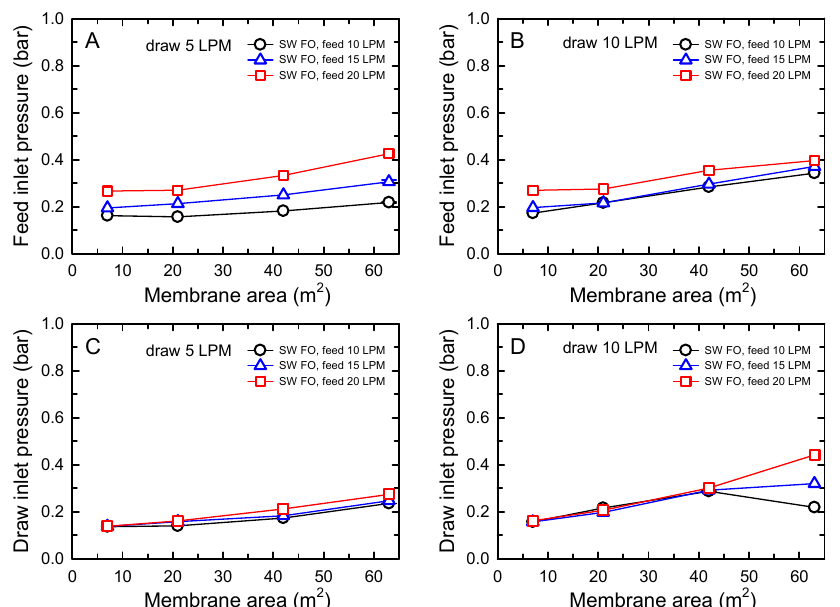
Figure A2. Inlet pressures in feed and draw channels of plate-and-frame (PF) forward osmosis (FO) as a function of membrane area. The applied direct solution (DS) flow rates were 5 ( A , C ) and 10 LPM ( B , D ). The feed solution (FS) flow rates were fixed at 10 LPM. The membrane areas were adjusted via serial connection of 1, 3, 6, and 9 elements of PF FO. The concentrations of FS and DS were 10 and 70 g/L, respectively.